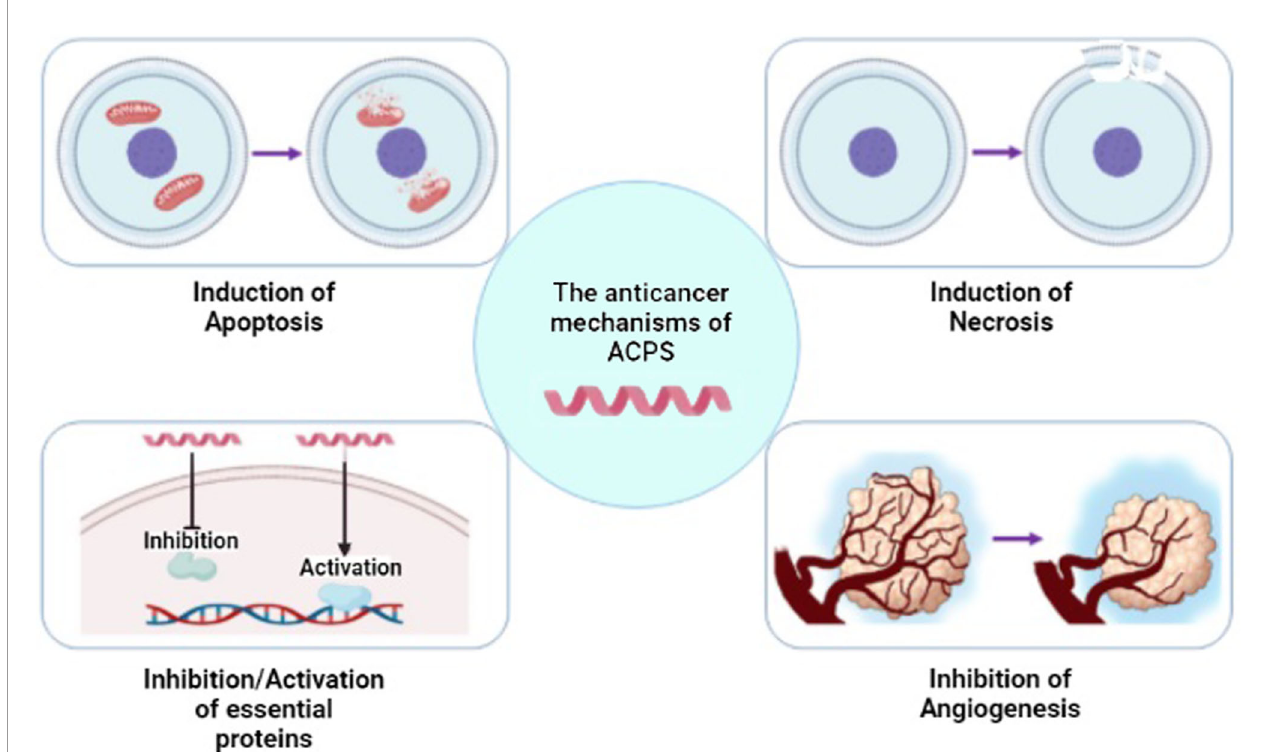
FIGURE 4 | Different mechanisms of anticancer peptide (ACP) function. ACPs can function through a variety of mechanisms, including apoptosis or necrosis induction of cancer cells, activation/inhibition of proteins, and inhibition of angiogenesis [modi fi ed from ref (87)]. (Created with